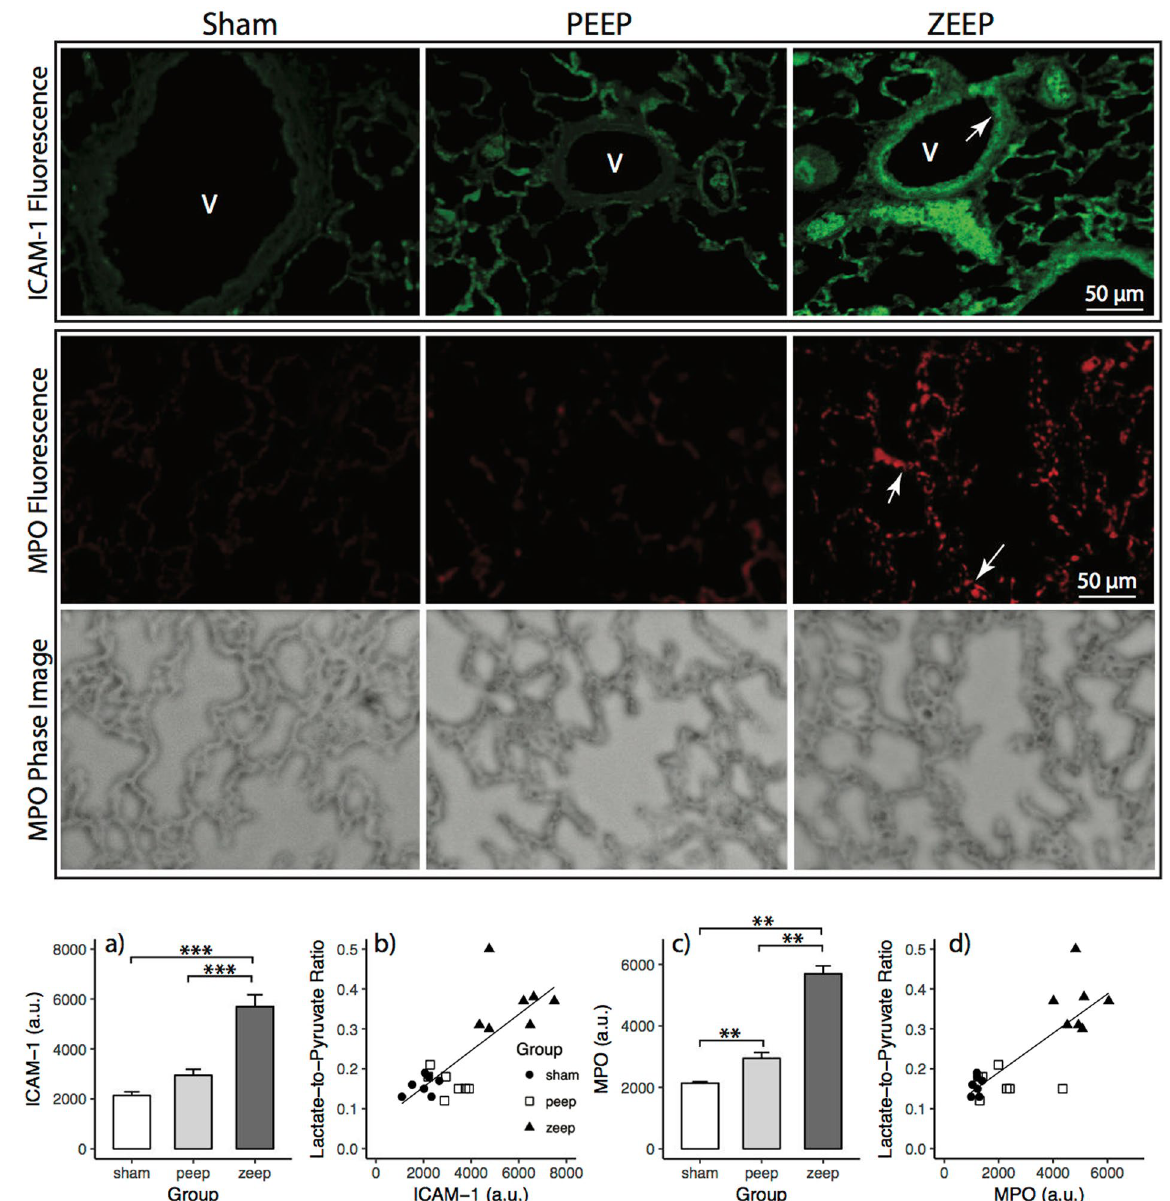
Figure 6. (Top) ICAM-1 expression in lung sections measured by fluorescence microscopy (40 × magnification). Green fluorescence denotes ICAM-1 expression, which is higher in the ZEEP group in response to inflammatory stimuli. Additionally, the green fluorescence is higher along the endothelial layer that lines the vessels (indicated by white arrows (V)). (Middle) MPO expression in the lung sections measured by fluorescence microscopy (40 × magnification). Red fluorescence denotes higher MPO expression, which is similar in both sham and PEEP lungs, but much higher in the ZEEP lungs. The white arrows illustrate the punctate staining from neutrophils. The phase images for the same sections show the structure of the lung tissue. The scale bar is 50 µ m. (Bottom) ICAM-1 expression was significantly different among groups (F 2,18 = 37.76, p < 0.001), and was significantly higher in the ZEEP group relative to the PEEP (p = 0.002) and sham ( p = 0.002) groups ( a ). ICAM-1 expression was strongly correlated with the average lactate-to-pyruvate ratio measured 4 hours after acid/saline instillation ( r = 0.782, p < 0.001) ( b ). There was significantly different MPO expression among groups ( χ 2 (2) = 16.416, p < 0.001); the measured activity was significantly higher in the ZEEP group compared to the PEEP ( p = 0.002) and sham ( p = 0.002) groups ( c ), and was strongly correlated with the average lactate-to-pyruvate ( r = 0.817, p < 0.001) ( d ). The activity was also significantly different between the PEEP and sham groups ( p = 0.004). ( ** p < 0.01, *** p <